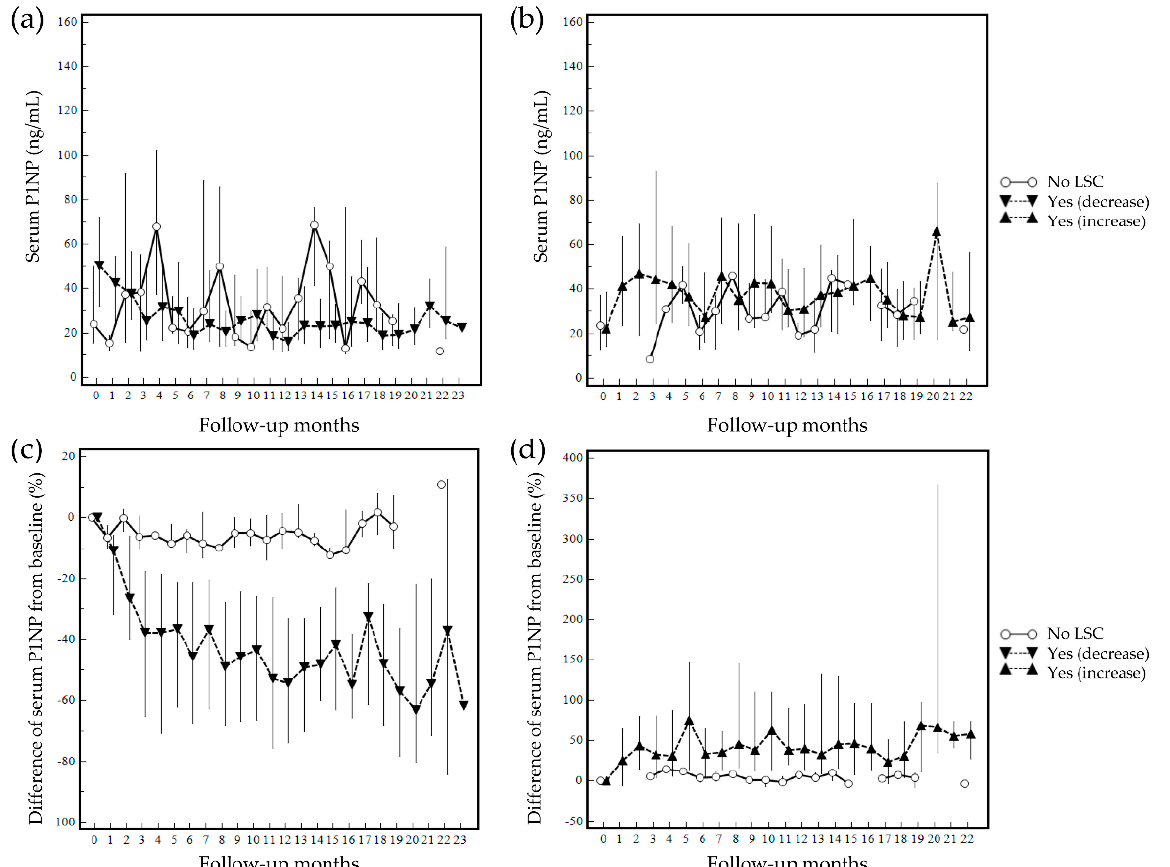
Figure 6. Changes in serum P1NP at follow-up (median serum P1NP level by follow-up month is presented and grouped based on least significant changes (LSC) ≥ 14.4% from baseline): ( a ) quantitative changes in patients who experienced a decrease in P1NP during follow-up; ( b ) quantitative changes in patients who experienced an increase in P1NP during follow-up; ( c ) %difference from baseline in patients who experienced a decrease in P1NP during follow-up; ( d ) %difference from baseline in patients who experienced an increase in P1NP during follow-up. ‘No’ represents no achievement of least significant changes, and ‘Yes’ represents an achievement of least significant changes.